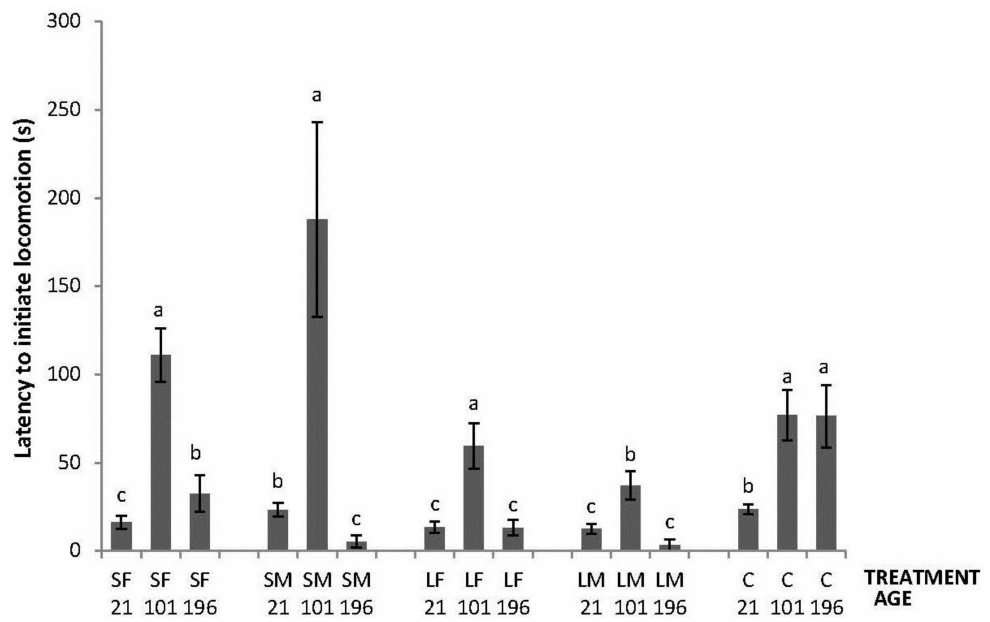
Figure 2. Latency to initiate locomotion in a 520 s open-field test by 21, 101 and 196 days old layers from the control and four brooder treatments. Bars with no common letters differ significantly (mixed model ANOVA: p < 0.05). Treatments = SF: small fixed brooder; SM: small movable brooder; LF: large fixed brooder; LM: Large movable brooder; C: